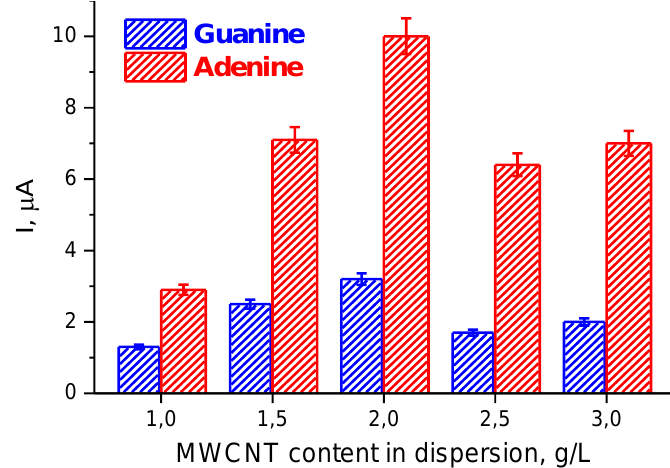
Figure 3. The current intensities of the DPV peaks for electrooxidation of the guanine (blue) and adenine (red) residues of dsDNA for different concentrations of MWCNTs in the (P n BMA 40 - b - PDMAEMA 120 + MWCNT) dispersions. Conditions: dsDNA was deposited onto the SPE/(P n BMA 40 - b -PDMAEMA 120 + MWCNT_n) constructs from a 1500 µg/ml solution. The incubation time after dsDNA deposition was 15 min.